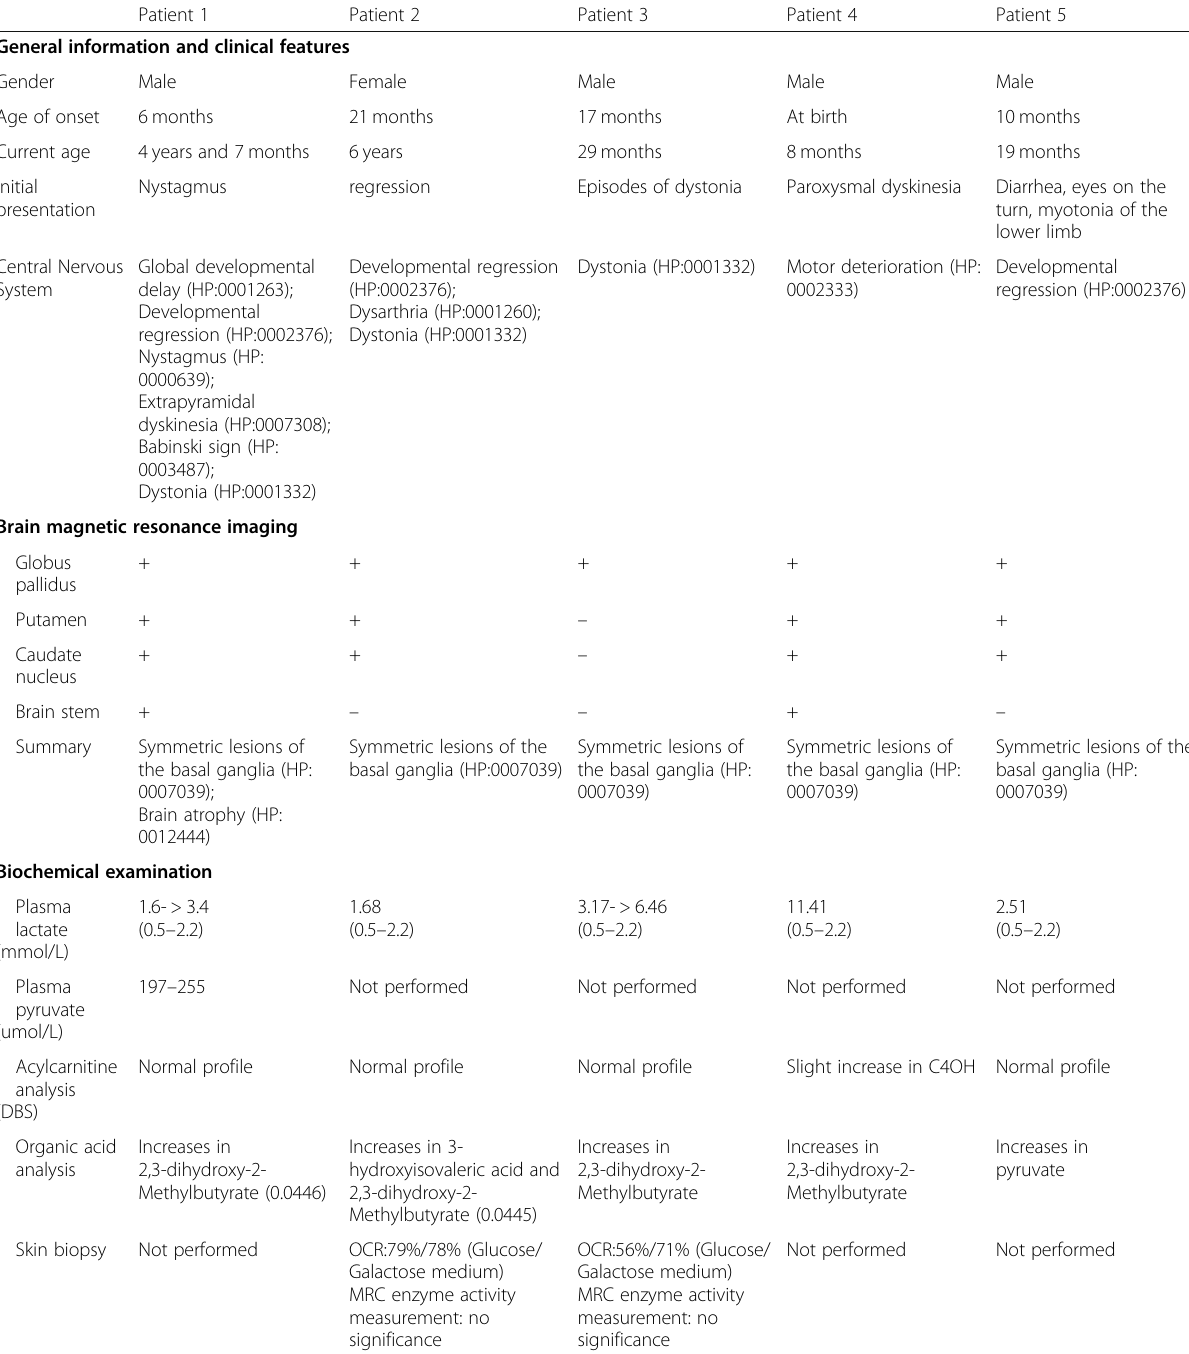
Table 1 Summary of general information, clinical features, brain magnetic resonance imaging and biochemical examinations of five